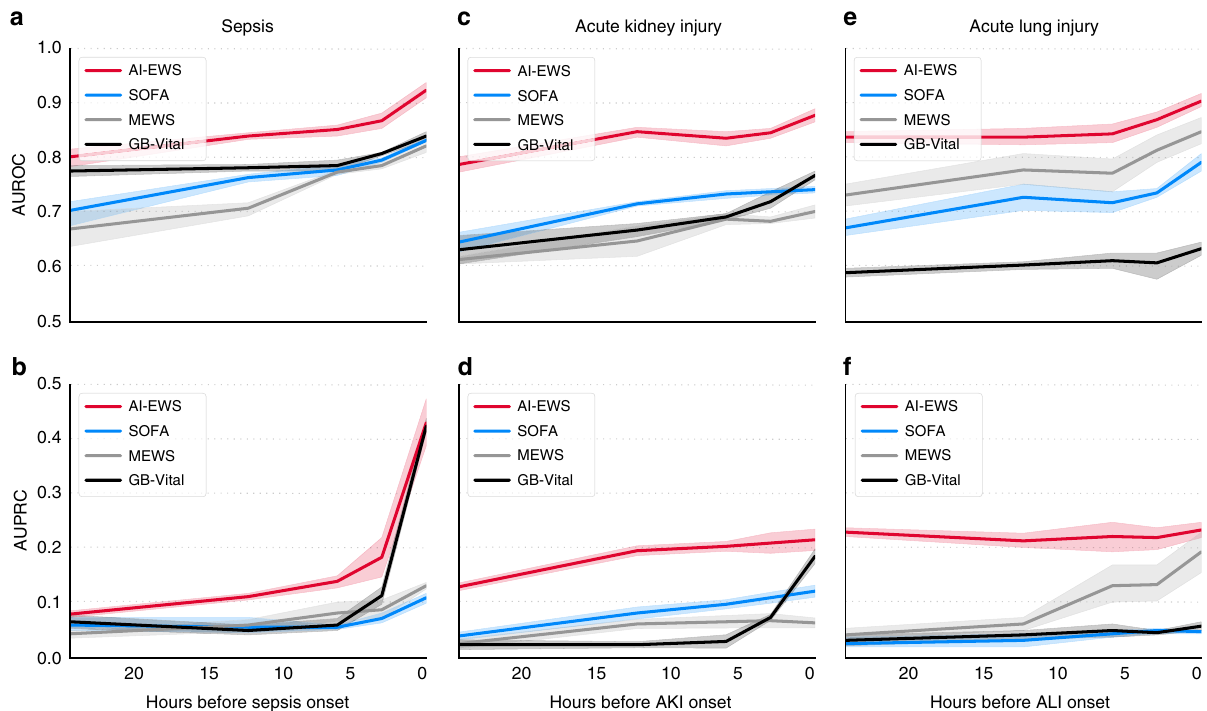
Fig. 2 Predictive performance of the xAI-EWS. The xAI-EWS results are compared with those from MEWS, SOFA, and the gradient boosting vital sign model (GB-Vital). Predictive performance is shown from the onset time to 24 h before onset. AUROC performance is shown for sepsis ( a ), AKI ( c ), and ALI ( e ), and AUPRC performance is shown for sepsis ( b ), AKI ( d ), and ALI ( f ). The solid lines indicate mean values. Lighter semitransparent colors surrounding the solid lines indicate uncertainty by 95% con fi dence intervals calculated from the fi ve test datasets ( n = 163,050 patients examined over 5 cross- validation folds with a test size of 10%).